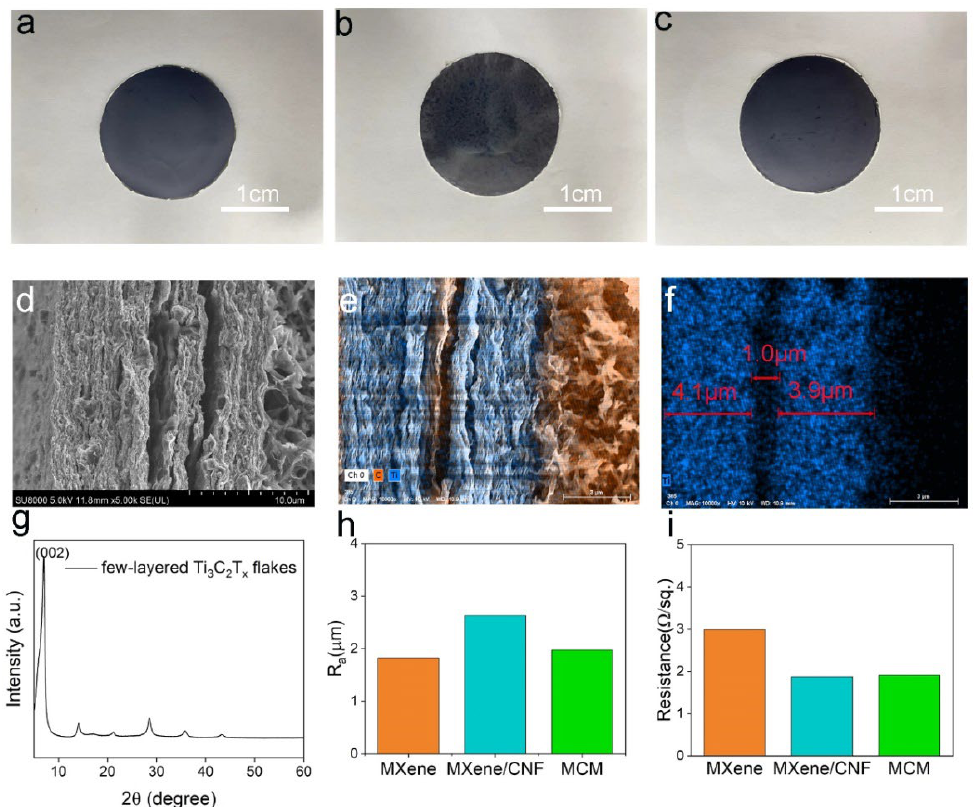
Figure 2. Characteristics of the MCM film. ( a – c ) Photographs of MXene, MXene/CNF, and MCM films. ( d ) SEM image of the lateral section of MCM film. ( e ) The energy-dispersive spectrometer of MCM film. ( f ) The Ti element distribution in the MCM film. ( g ) The XRD pattern of few-layered MXene. ( h ) The surface roughness of MXene, MXene/CNF, and MCM films. ( i ) The sheet resistances of MXene, MXene/CNF, and MCM